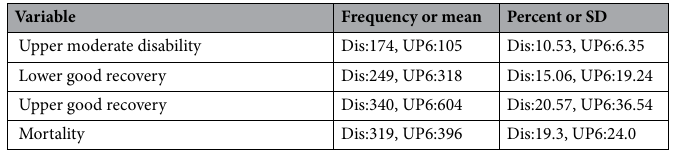
Table 1. Details of our dataset features: the second/third column contains frequency/percent for discrete features and mean/standard-deviation for continuous ones, respectively. *Dis stands for Discharge. **UP6 stands for Up to 6 months.